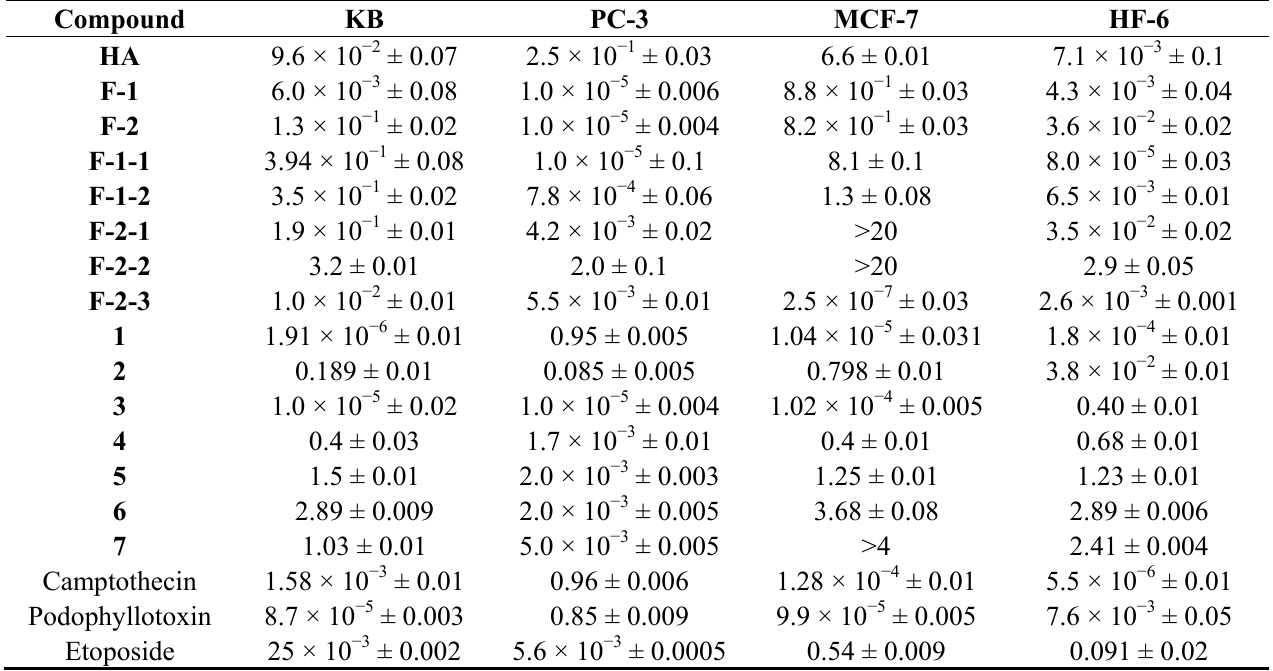
Table 1. ED Values ( μ g/mL) of Extract, Fractions, and Active Compounds Isolated from 50 B. fagaroides var. fagaroides against four human cancer cell lines.